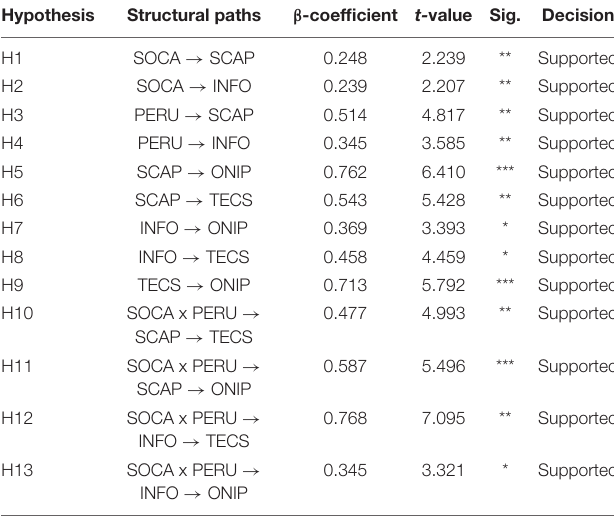
TABLE 6 | Hypotheses testing results of the